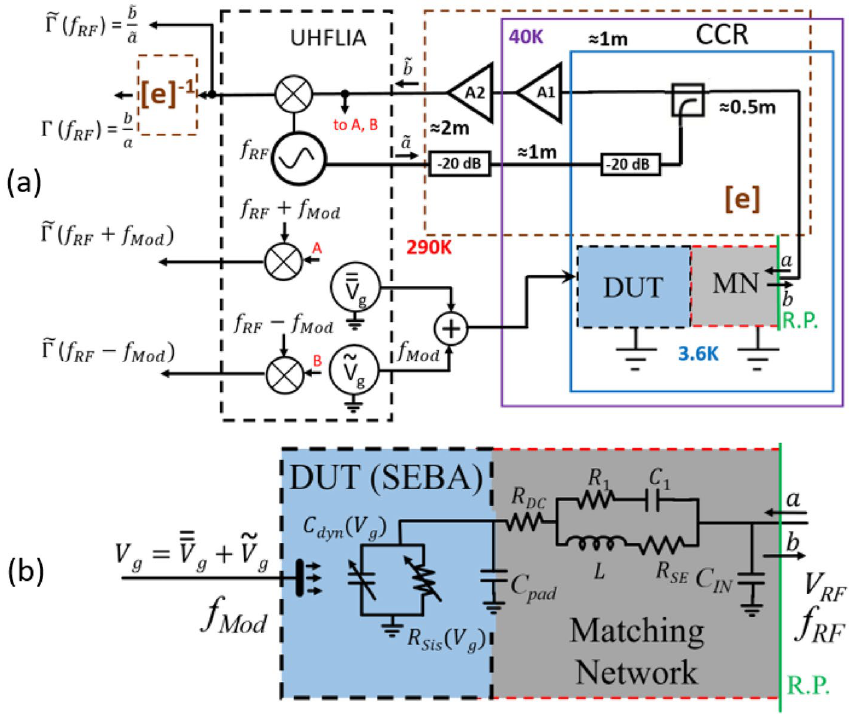
Figure 2. ( a ) Experimental setup. Components surrounded by a violet line are inside close cycle refrigerator (CCR), with cold amplifier A1 at 40 K. Components within blue box are at T = 3.6 K. Dashed brown box labeled “[e] −1 ” contains all the components that contribute to non-idealities (”errors”) in the reflectometry process. Dashed brown box labeled ”[e] −1 ” is an ”error-correction box” implemented in software that generates error corrected data (ECD) by using calibrated standards to calculate error correction coefficients. UHFLIA is ZI UHF lock-in amplifier which generates all signals and performs demodulation. Dashed green line delineates the reference plane (R.P.). ( b ) Zoom-in into a combination of DUT and MN showing all of the circuit components. DUT is represented by SEBA; the SEBA admittance is controlled by the gate voltage V g . Pad capacitance, C pad , is shown as an element shared between MN and